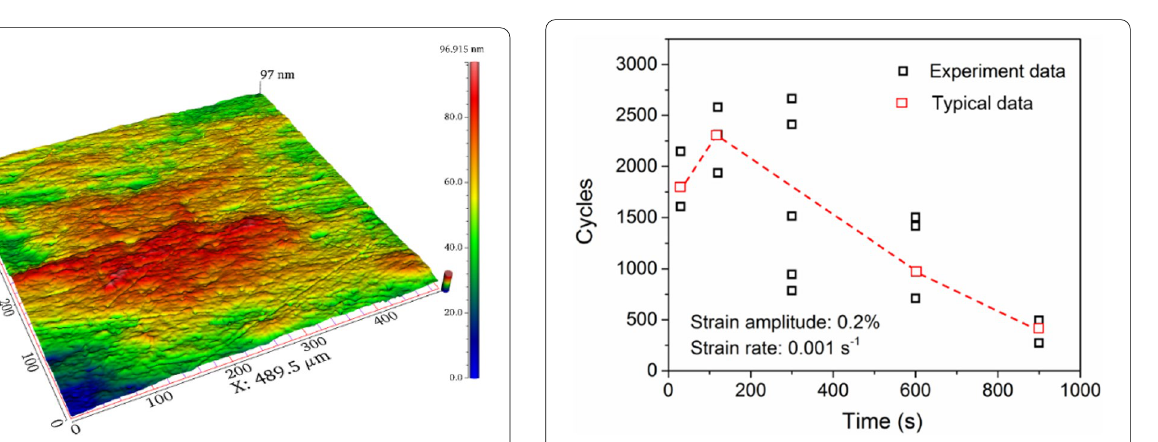
Figure 5 The effect of dwell time (30, 120, 300, 600 and 900 s) on the number of cycles to failure for 9%Cr steel welded joint at 650